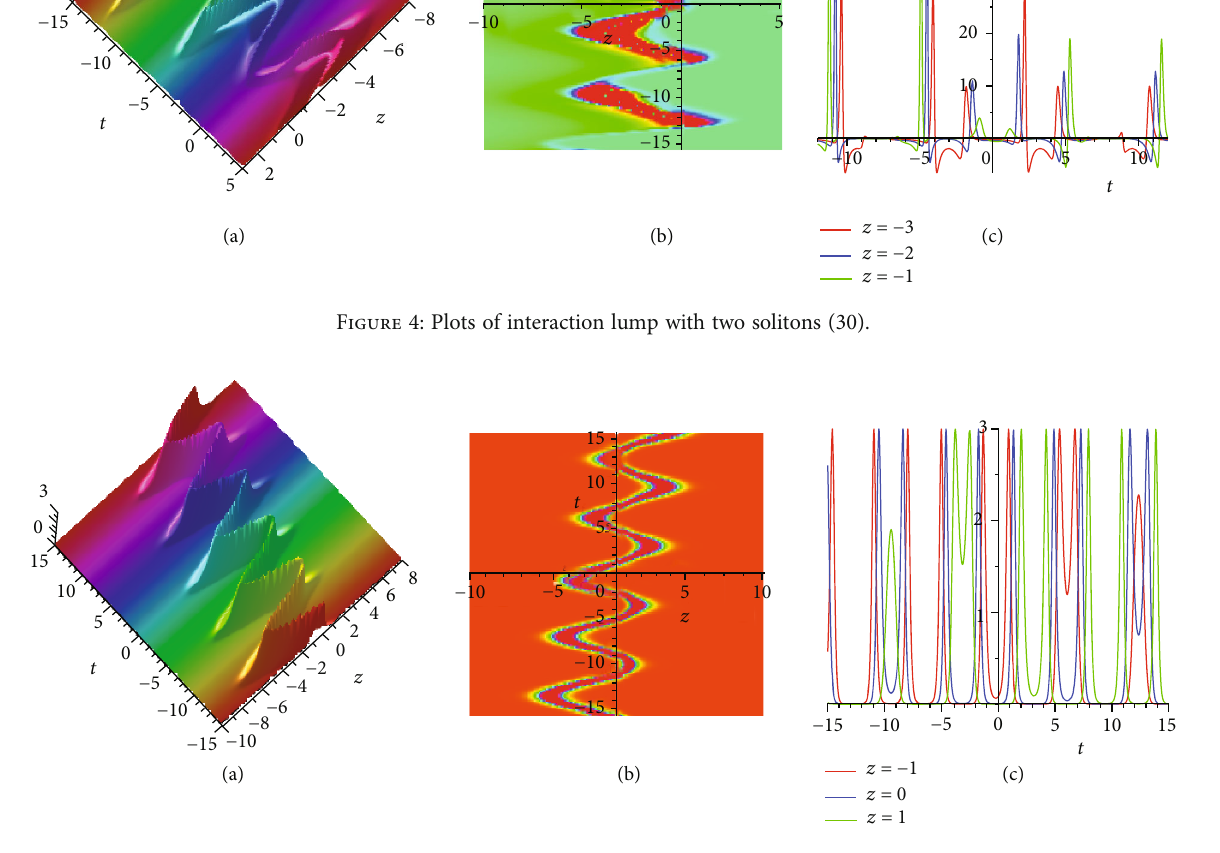
Figure 5: Plots of interaction lump with two solitons